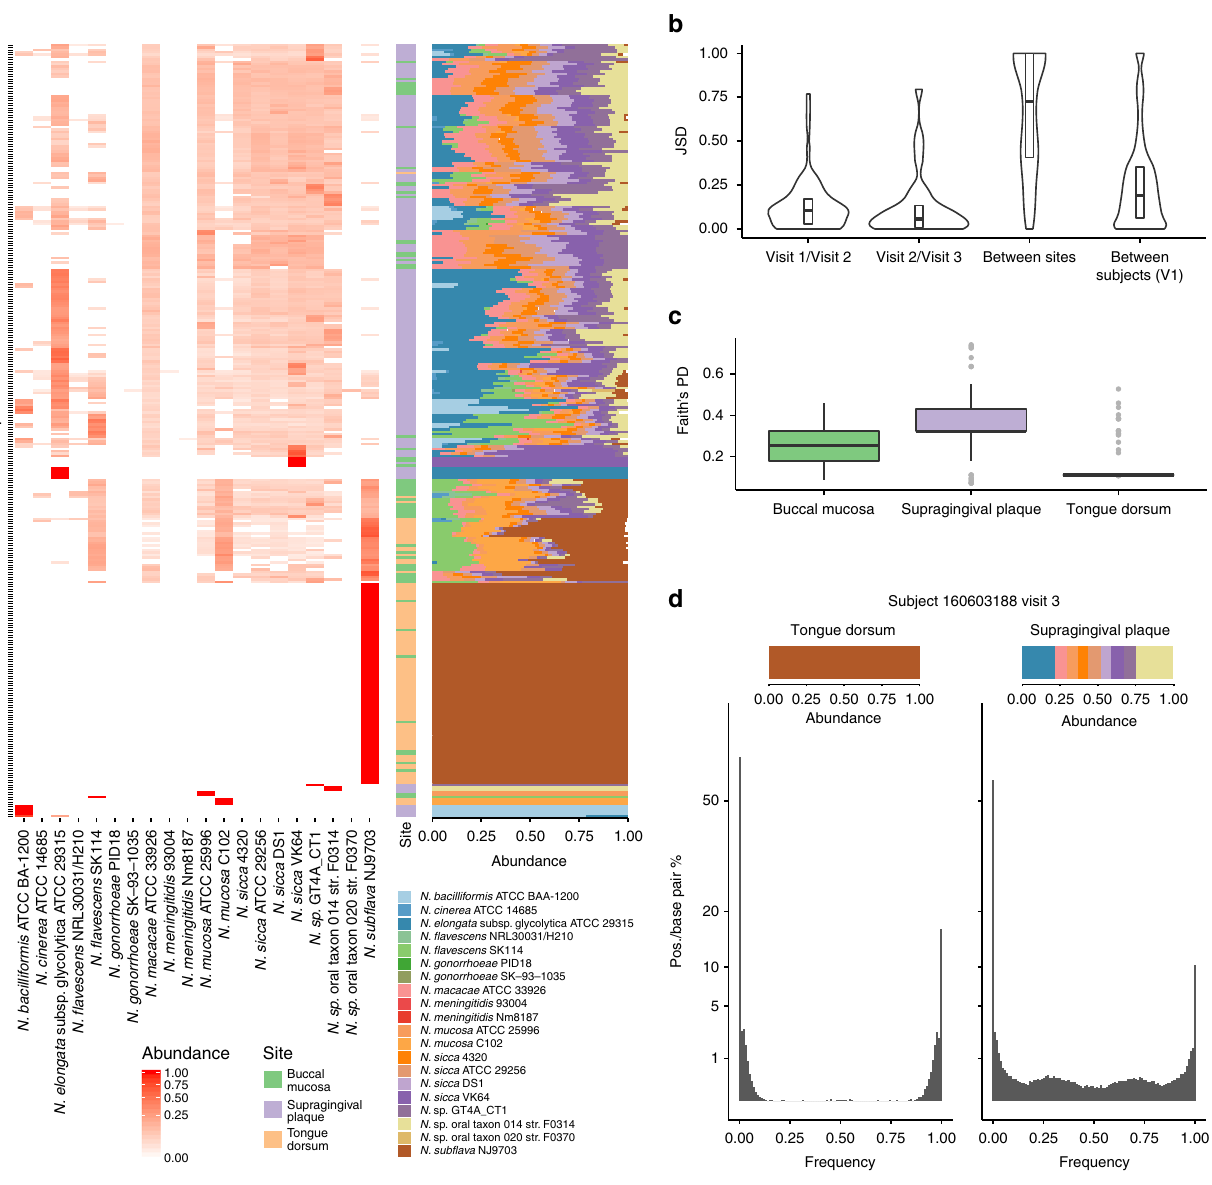
Fig. 5 StrainEst disentangles complex mixtures of neisseriae in 320 oral samples from the HMP. While tongue dorsum samples are dominated by N. sub fl ava , the other two sampling sites, namely the supragingival plaque and the buccal mucosa are characterized by much more complex communities ( a ) and ( c ). Samples are ordered by an average linkage hierarchical clustering (Bray – Curtis dissimilarity). The Jensen – Shannon divergence ( b ) is signi fi cantly higher between sites or between subjects than between visits in the same site/subject ( P < 0.001), suggesting that the population of Neisseria strains is stable over an extended period of times. d Distribution of site-speci fi c frequencies of the four possible nucleotides at each allelic position for two representative samples from the same subject. As in Fig. 1b, single-strain samples have a distribution with two peaks at frequencies close to 0 and 1. Complex communities are characterized by symmetric distributions with multiple peaks at intermediate values. In c , boxes extend to the fi rst and third quartile, whiskers extend to the upper and lower value within 1.5*IQR from the box. Outliers are shown as